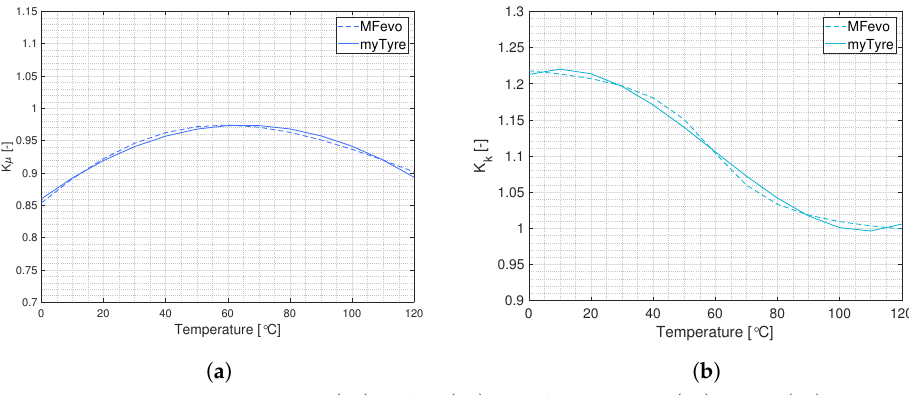
Figure 10. myTyre—connection ( K µ ( T s ) and K k ( T s ) ) validation. ( a ) K µ ( T s ) ; ( b ) K k ( T s ) . Figure 11 shows the performances of myTyre and MFevo for two temperature values. The thermal model was suppressed to check the performance of the Pacejka equation combined with the connecting equation (Equation (10)). The next section (Section 3.2) also shows the performance of myTyre in terms of inputs to the output longitudinal tyre force F x as compared to the MFevo and also the pure Pacejka-based tyre model (at reference temperature of 70 ◦ C) without temperature